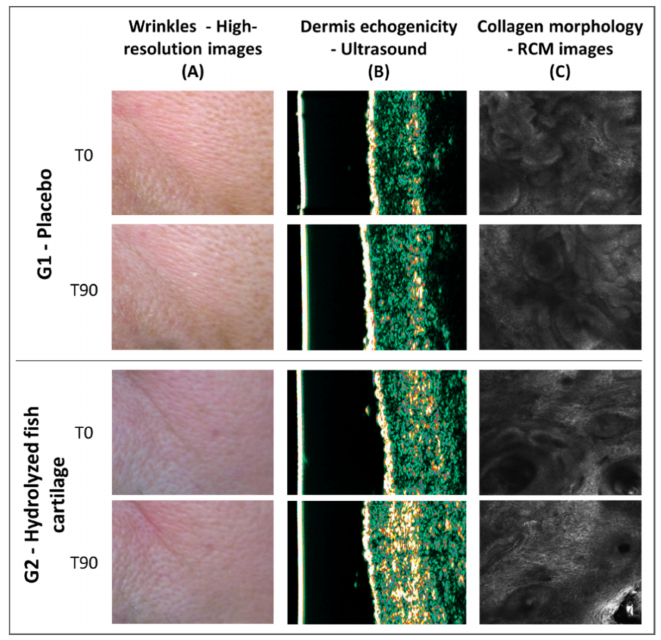
Figure 8. Representative images of skin showing wrinkle reduction ( A ), dermis echogenicity increase ( B ), and collagen morphology improvement ( C ) after a 90 day-period of supplementation with hydrolyzed fish cartilage (T90) compared to the baseline (T0) and to the